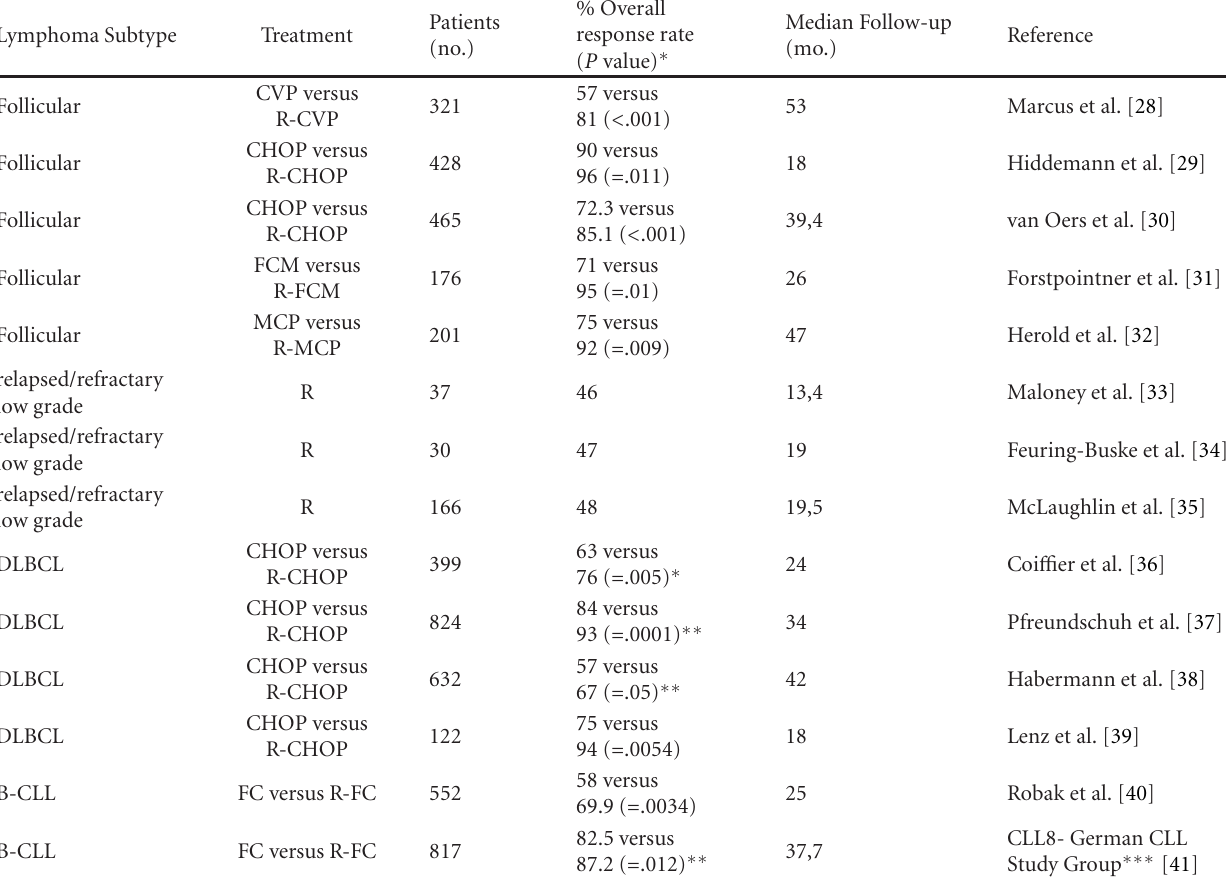
Table 1: Principal clinical trials of chemotherapy plus Rituximab versus chemotherapy alone in